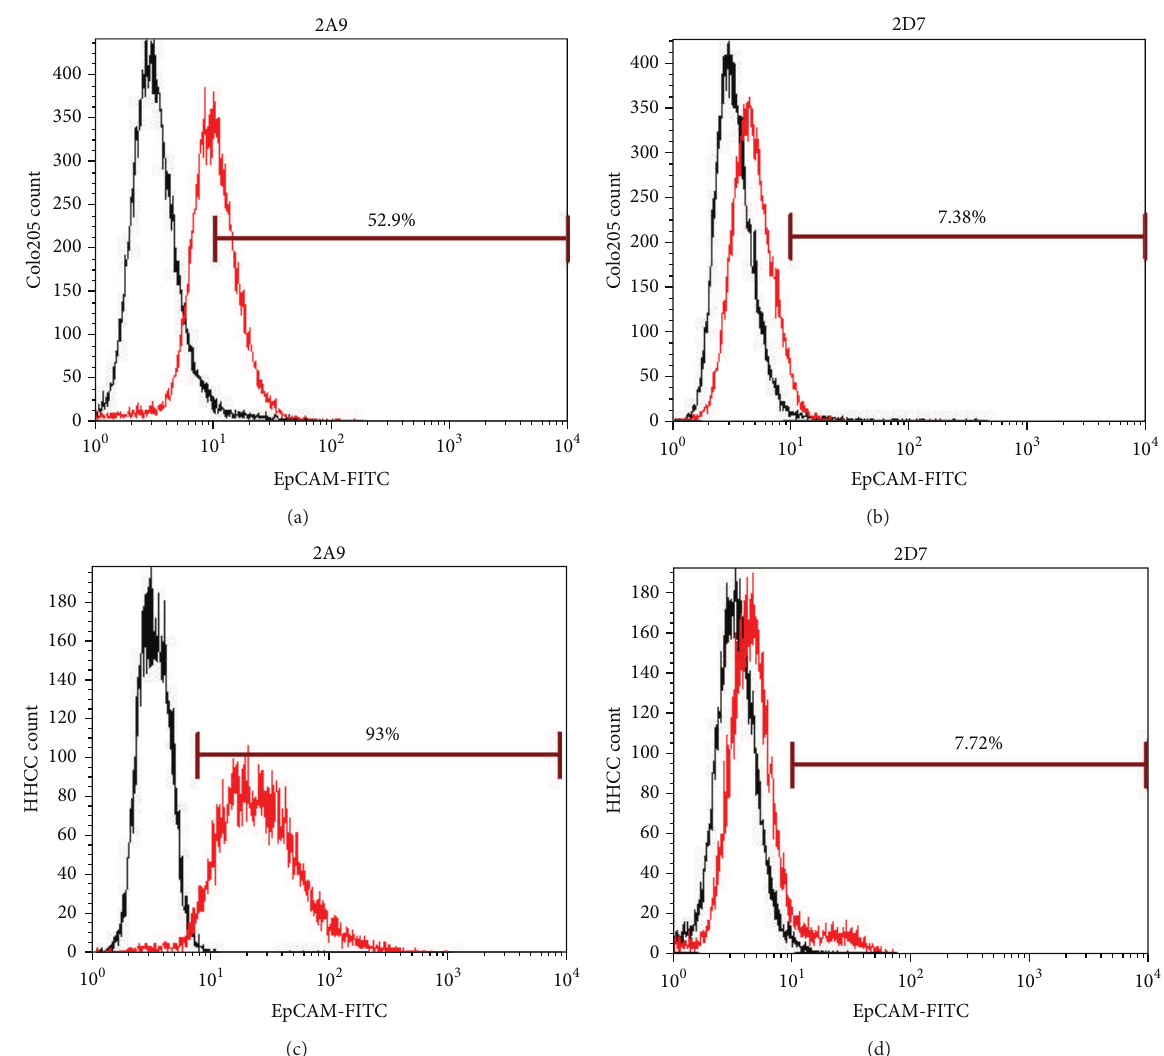
Figure 1: Binding ability of 2A9 and 2D7 to EpCAM was detected on Colo205 and HHCC cells by flow cytometry. Cells were incubated with biotin labeled EpCAM antibody (2A9 or 2D7, red histograms) or isotype control (black histograms) antibody (20 𝜇 g/mL) for 40 min at 4 ∘ C. Then cells were washed and stained with FITC-labeled secondary antibody and analyzed by flow